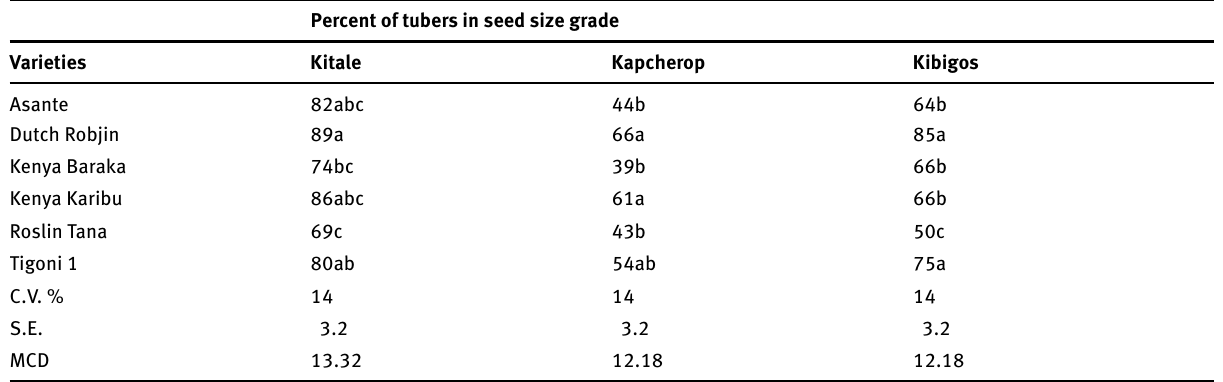
Table 4: Proportion of tuber yield in seed size category at the experimental sites Percent of tubers in seed size